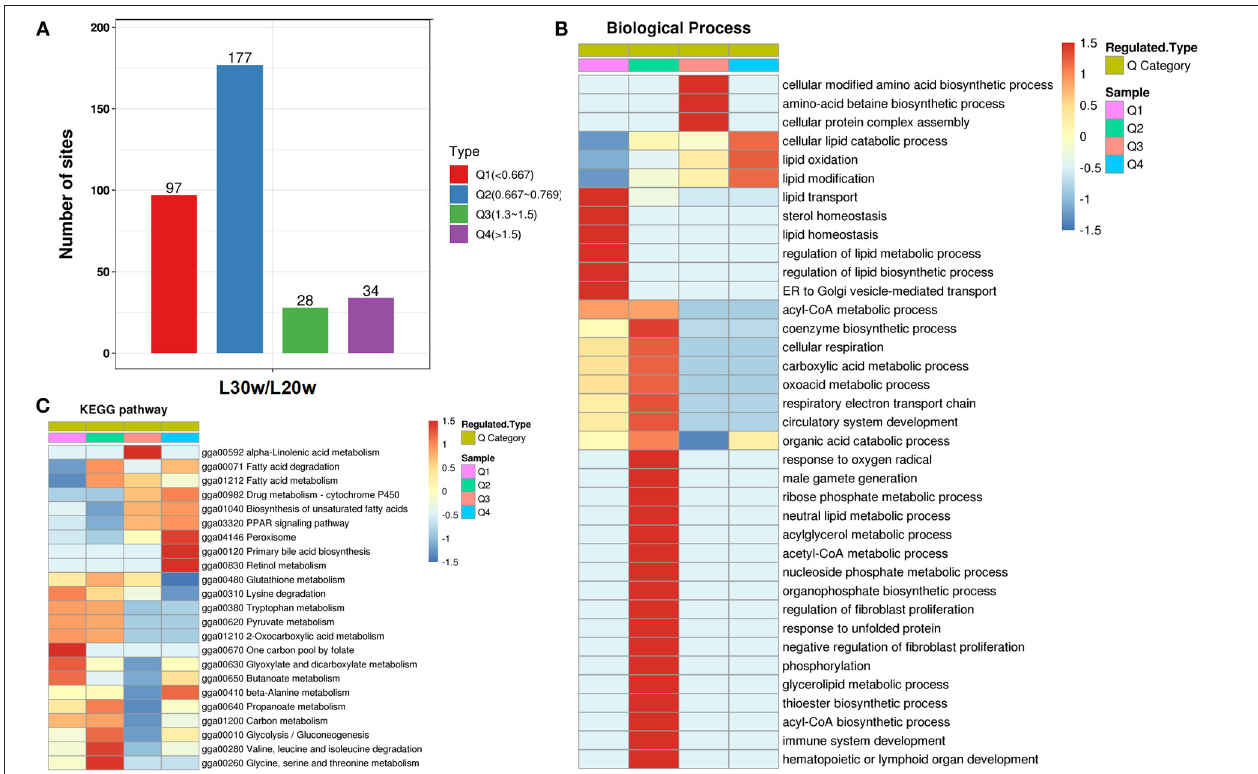
FIGURE 6 | Cluster analysis of differential kac proteins based on their differential acetylation multiples. (A) Distribution of differentially acetylated proteins. The differentially acetylated proteins were classified into four groups according to their fold changes of acetylation levels: Q1 (0 < Ratio ≤ 1/1.5), Q2 (1/1.5 < Ratio ≤ 1/1.2), Q3 (1.2 < Ratio ≤ 1.5) and Q4 (Ratio > 1.5). (B) GO enrichment analysis of differential kac proteins in four clusters. Only the significantly enriched ( p ≤ 0.05) biological process categories are shown. (C) KEGG enrichment analysis of differential kac proteins in four clusters. Only the significantly enriched ( p ≤ 0.05) pathways are